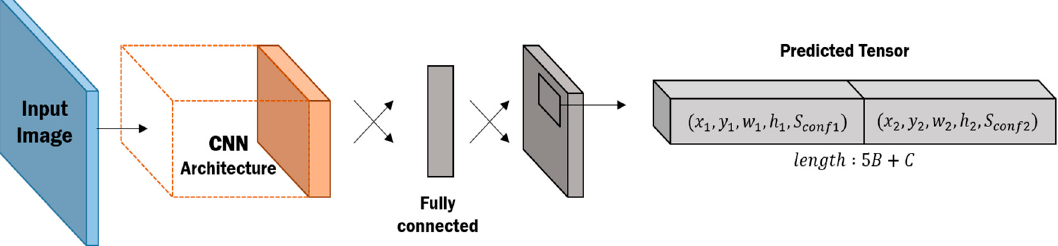
Figure 2. Structure of a You Only Look Once (YOLO) network.